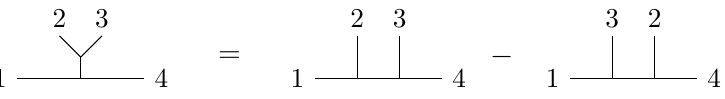
Figure 2 . The tree-level BCJ master diagrams are half-ladder diagrams with (cid:12)xed endpoints, which we choose to be legs 1 and n .